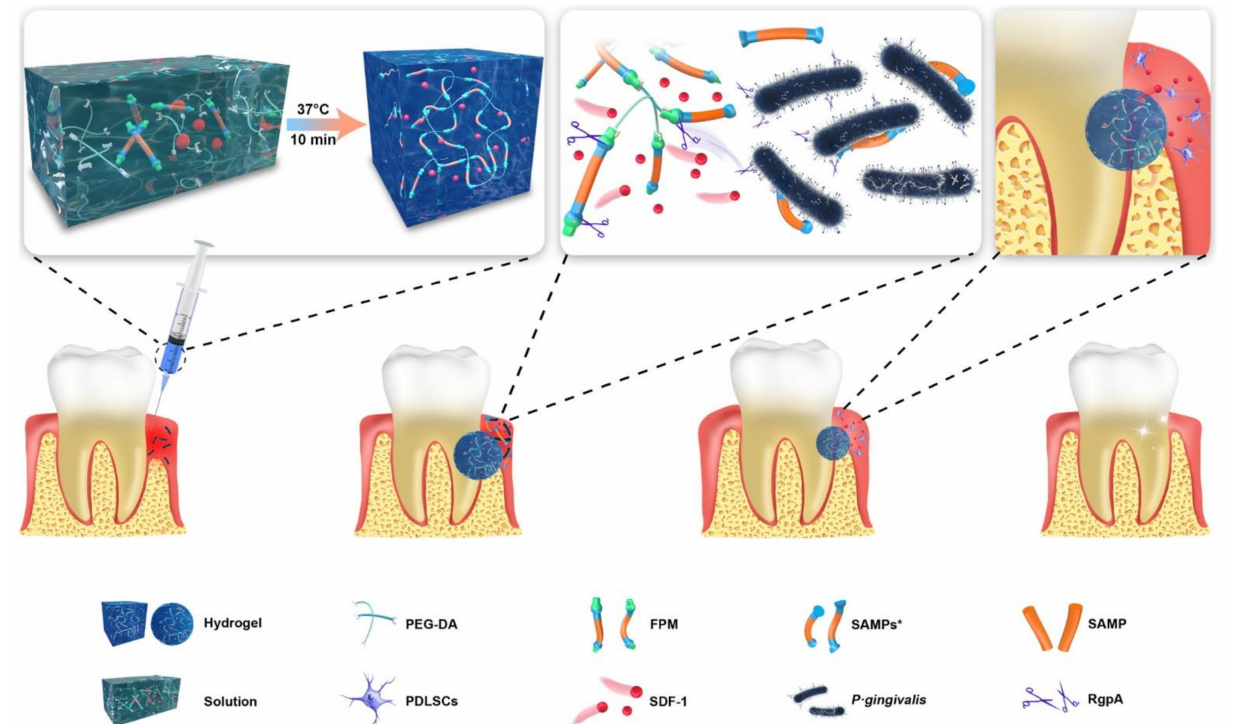
Figure 1. Schematic illustration of the composition and application of PEGPD@SDF-1 hydrogel. The hydrogel is cross-linked by FPM and PEG-DA and loaded with SDF-1. The transition from solution to hydrogel is completed at 37 ◦ C in 10 min. FPM contains SAMP in the center and two anchor peptides with specific splicing sites in the lateral. The RgpA released by P. gingivalis initiates splicing of the specific sites in FPM. Then, SAMPs* and SDF-1 are released to resist P. gingivalis and promote osteogenesis, respectively. Reprinted with permission from reference [13]. Copyright 2021 American Chemical